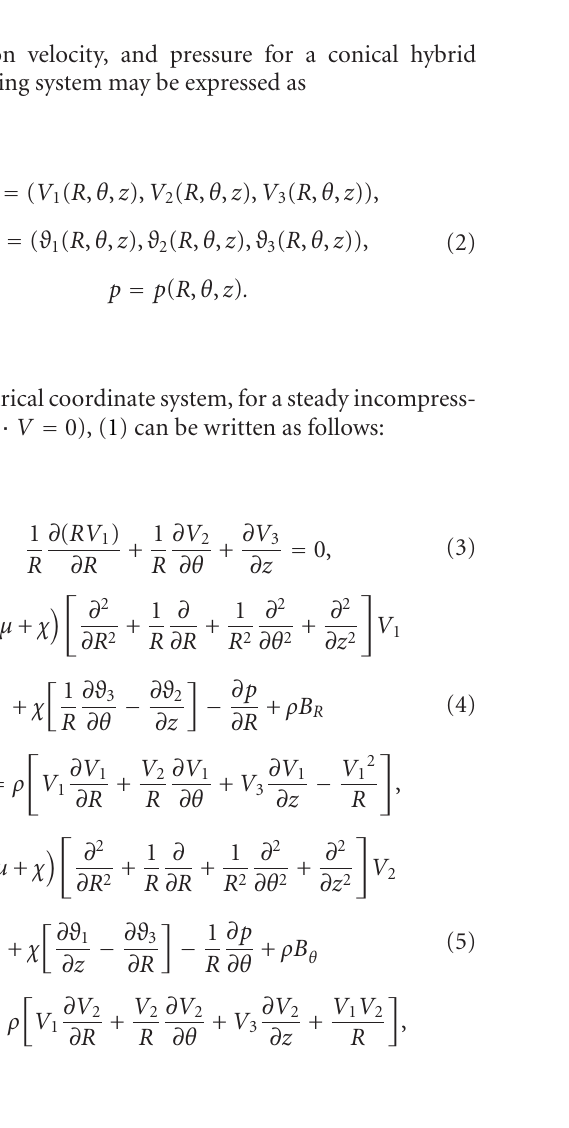
Figure 1: (a) Schematic of conical journal bearing system. (b) Developed surfaces of conical journal bearing system in cylindrical